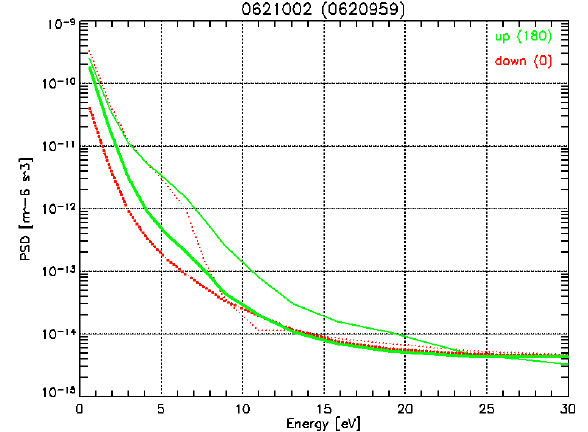
Fig. 9. Energy shift between distributions functions of Fig.